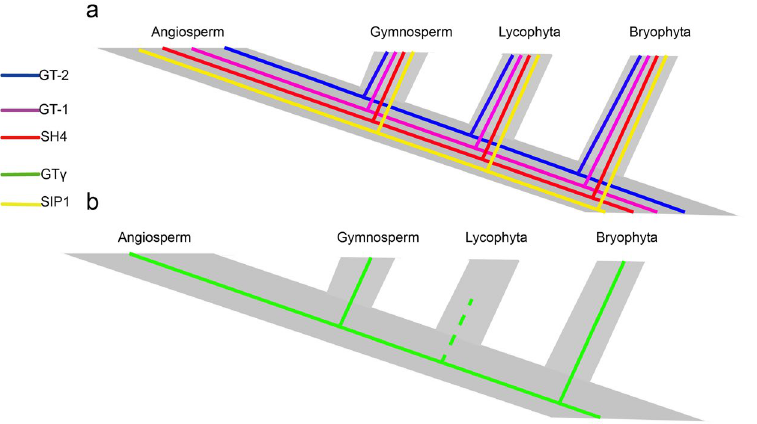
Figure 10. Evolutionary history of the trihelix family in plants. ( a ) GT-2, GT-1, SH4, SIP1 (indicated by different colors) exist in the course of evolution from Bryophyta to Angiosperm. ( b ) GT γ (indicated by green line) exists in the course of evolution from Bryophyta to Angiosperm except Lycophyta (dummy line indicates